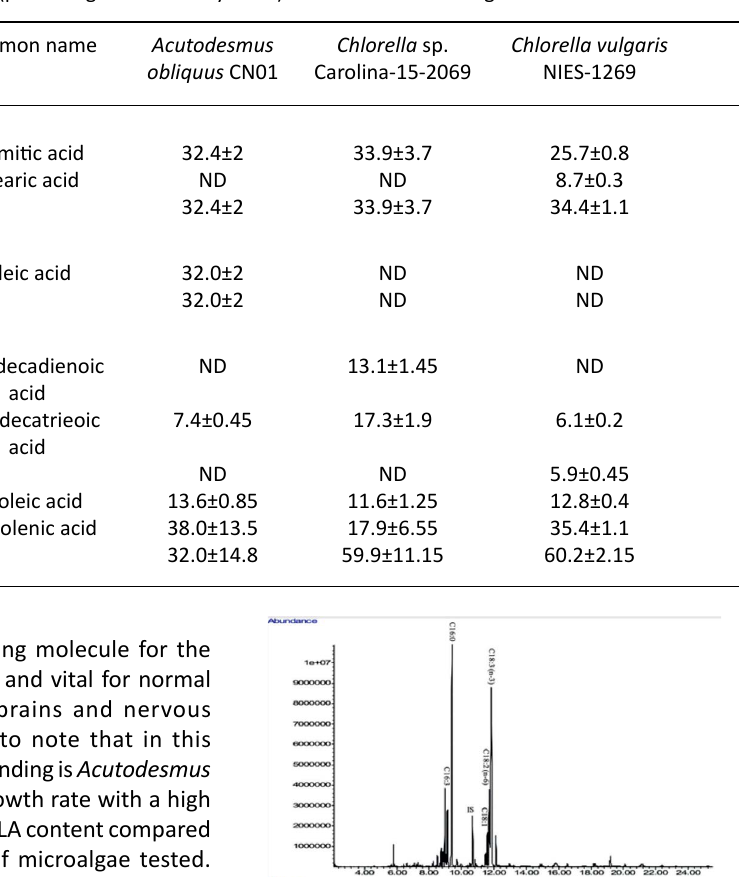
Fig. 5a. GC-MS chromatograms of FAME derived from freeze-dried biomass of freshwater green algae Acutodesmus obliquus CN01 (see Table 2 for peak identification). * Heptadecanoic acid (C17:0) was used as an internal standard.